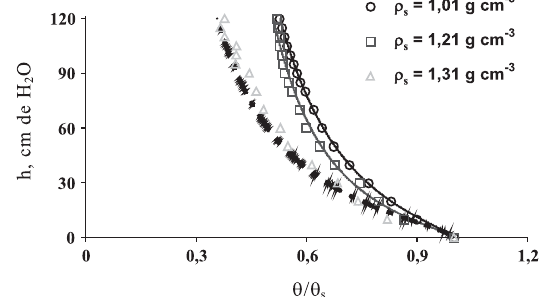
Figura 4. Curvas de retenção obtidas para os agregados de solo . Os pontos correspondem aos valores experimentais e as linhas representam as curvas ajustadas pelo modelo de van